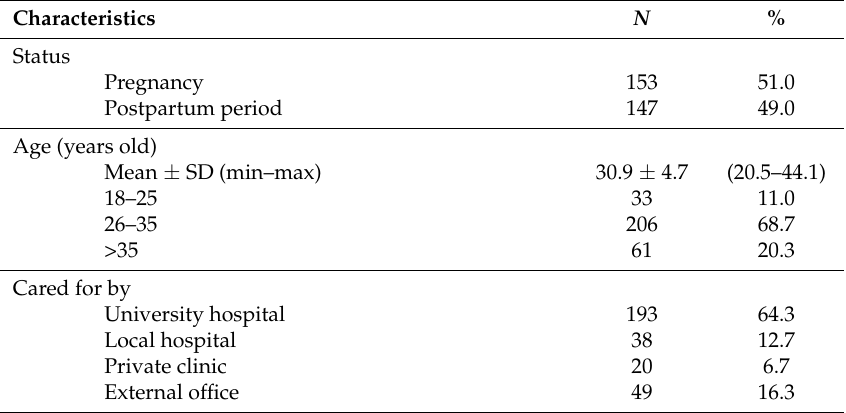
Table 1. Women’s